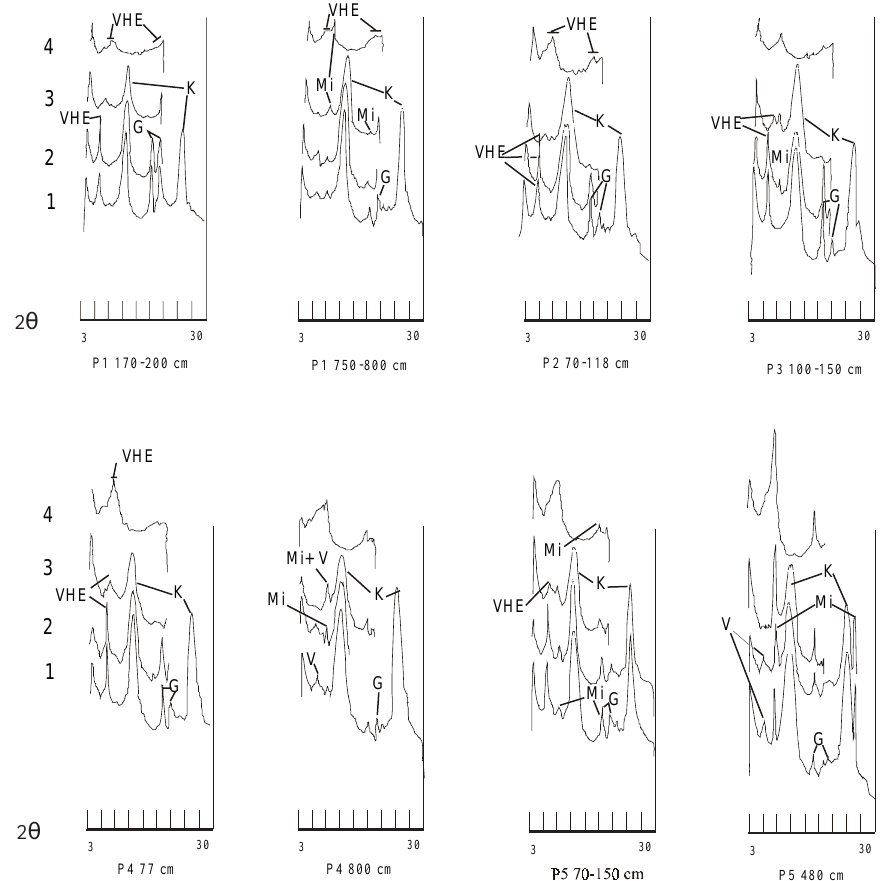
Figura 5. Difratogramas da fração argila de amostras dos horizontes dos pedons estudados. Tratamentos: (1) K + 25 o C; (2) Mg 2+ 25 o C, glicolada; (3) K + , 350 o C; (4) K + 550 o C. Mi: mica (ilita); V: vermiculita; VHE (vermiculta com hidróxi entrecamadas); K: caulinita; G: